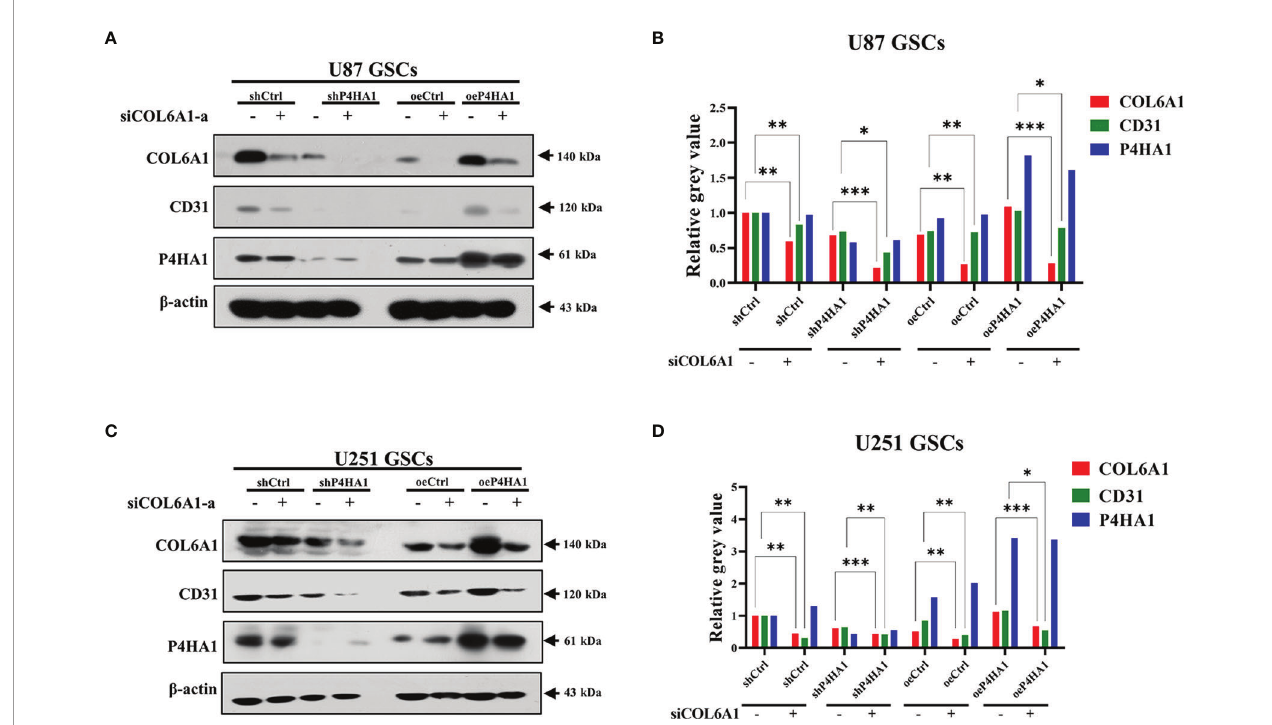
FIGURE 6 | Silence of COL6A1 interrupts the promotion of P4HA1 in hypoxia-induced GSCs transdifferentiation. (A, C) U87 GSCs (A) or U251 (C) GSCs knocked down (sh P4HA1) or overexpressing P4HA1 (oeP4HA1) were transfected with siRNA interfering with control (siNC) or COL6A1 (siCOL6A1-a). 3 days of hypoxia induction was performed after transfection and cells were then collected, lysed and subjected to SDS-PAGE. Western assays were performed to detect expression of CD31, COL6A1, P4HA1 and b -actin with the indicated antibodies. (B, D) Gray calculation of A(B) or C(D). The gray value of each band was divided by the corresponding gray value of the actin band. All results were normalized to the grey value of the band of U87 GSC-derived or U251 GSC-derived ECs transfected with the shCtrl group. *P < 0.05, **P < 0.01, ***P <